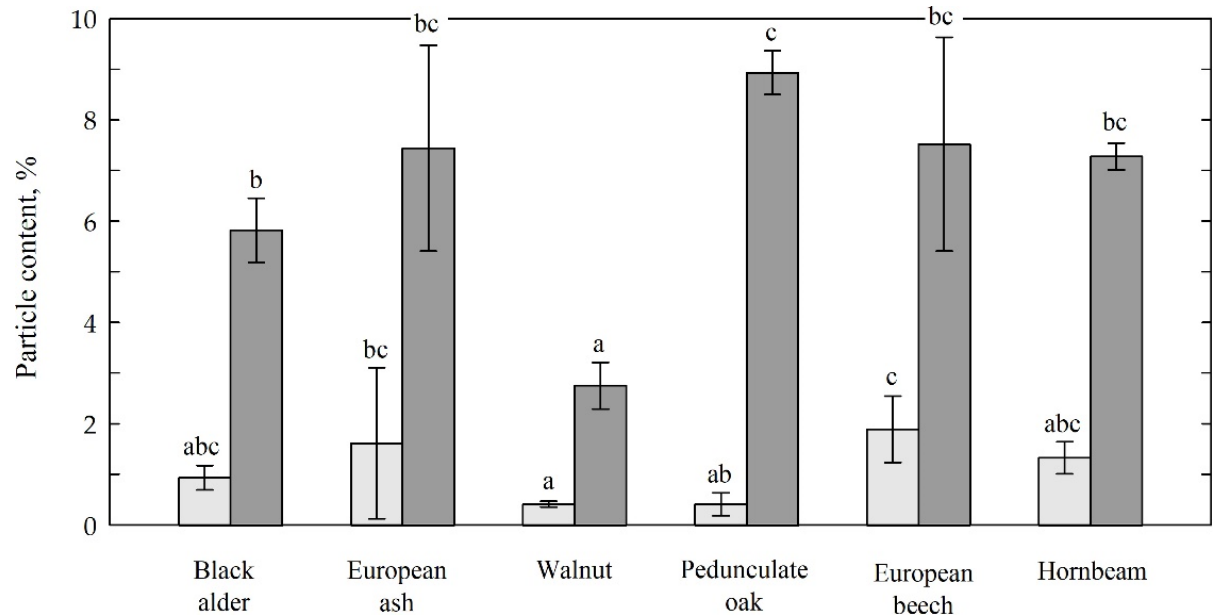
Figure 4. The mean content of particles <2.5 µ m ( gray ) and <10 µ m ( dark gray ); identical superscripts (a, b, c) denote no significant difference ( p < 0.05), n = 9 ± standard deviation.